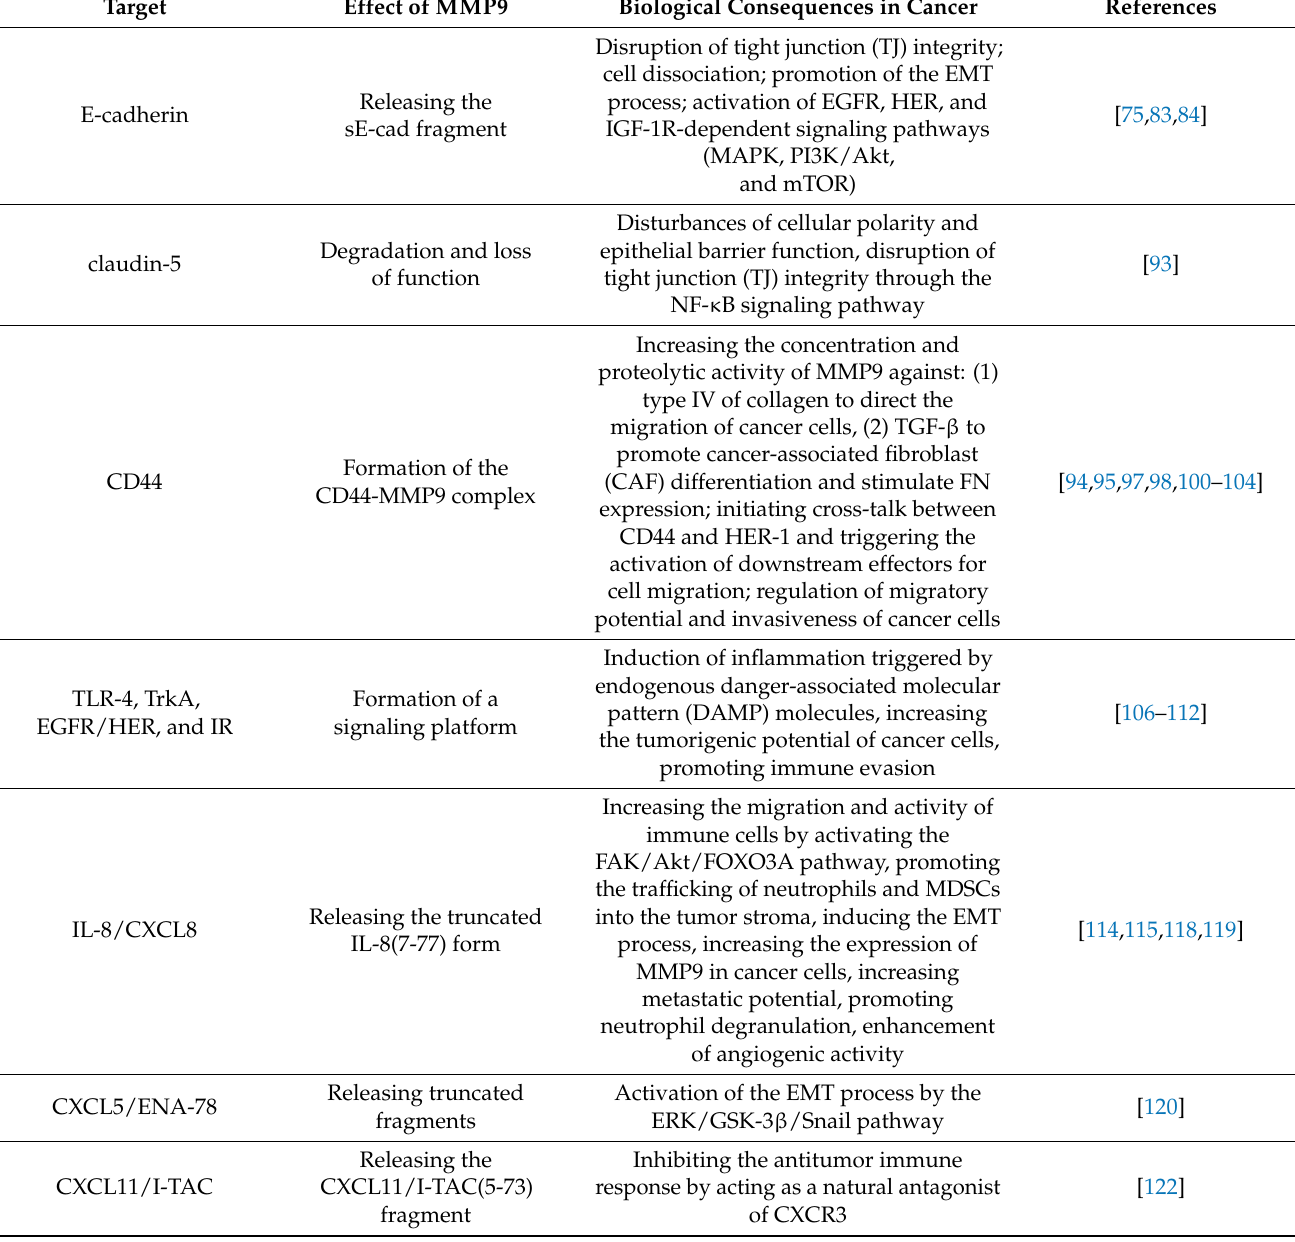
Table 1. The effect of MMP9 on tumor